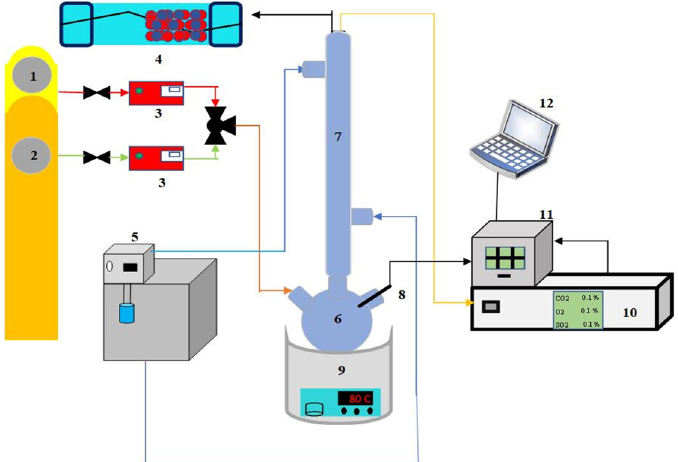
Figure 1. CO 2 capture experiment setup. (1) N 2 cylinder, (2) mixed gas cylinder, (3) mass flow controller, (4) desiccator, (5) thermostatic bath, (6) 500 mL three ‐ necked flask, (7) condenser, (8) thermocouple, (9) heater/stirrer, (10) gas analyzer, (11) paperless recorder, (12) laptop. Pure N 2 (1) was used during the CO 2 desorption step to flush out residual gas at the end of each desorption experiment. The mixed gas (2) was also used to calibrate the